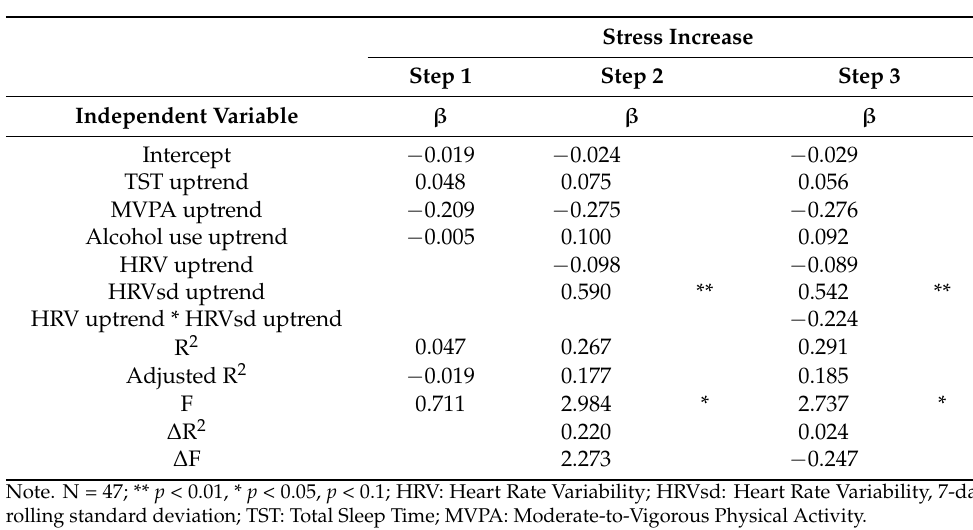
Table 2. Hierarchical multiple regression model for five-week stress increase.